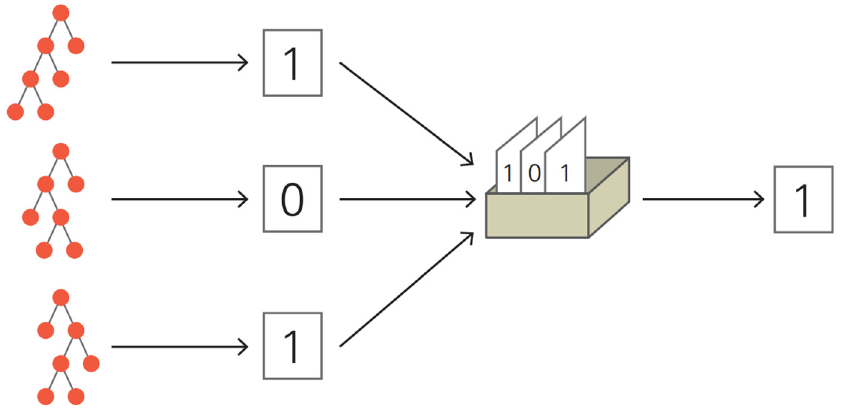
Figure 3. Schematic of random forest.